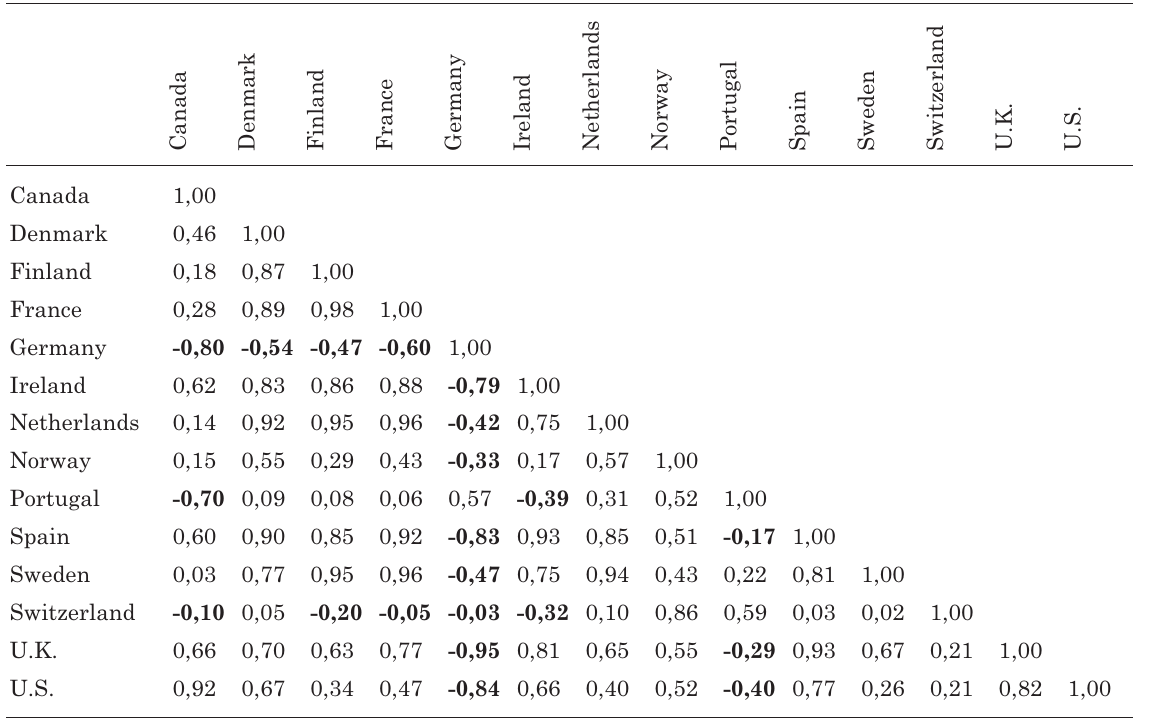
Table 8. Correlation matrix for international property returns (unhedged returns)